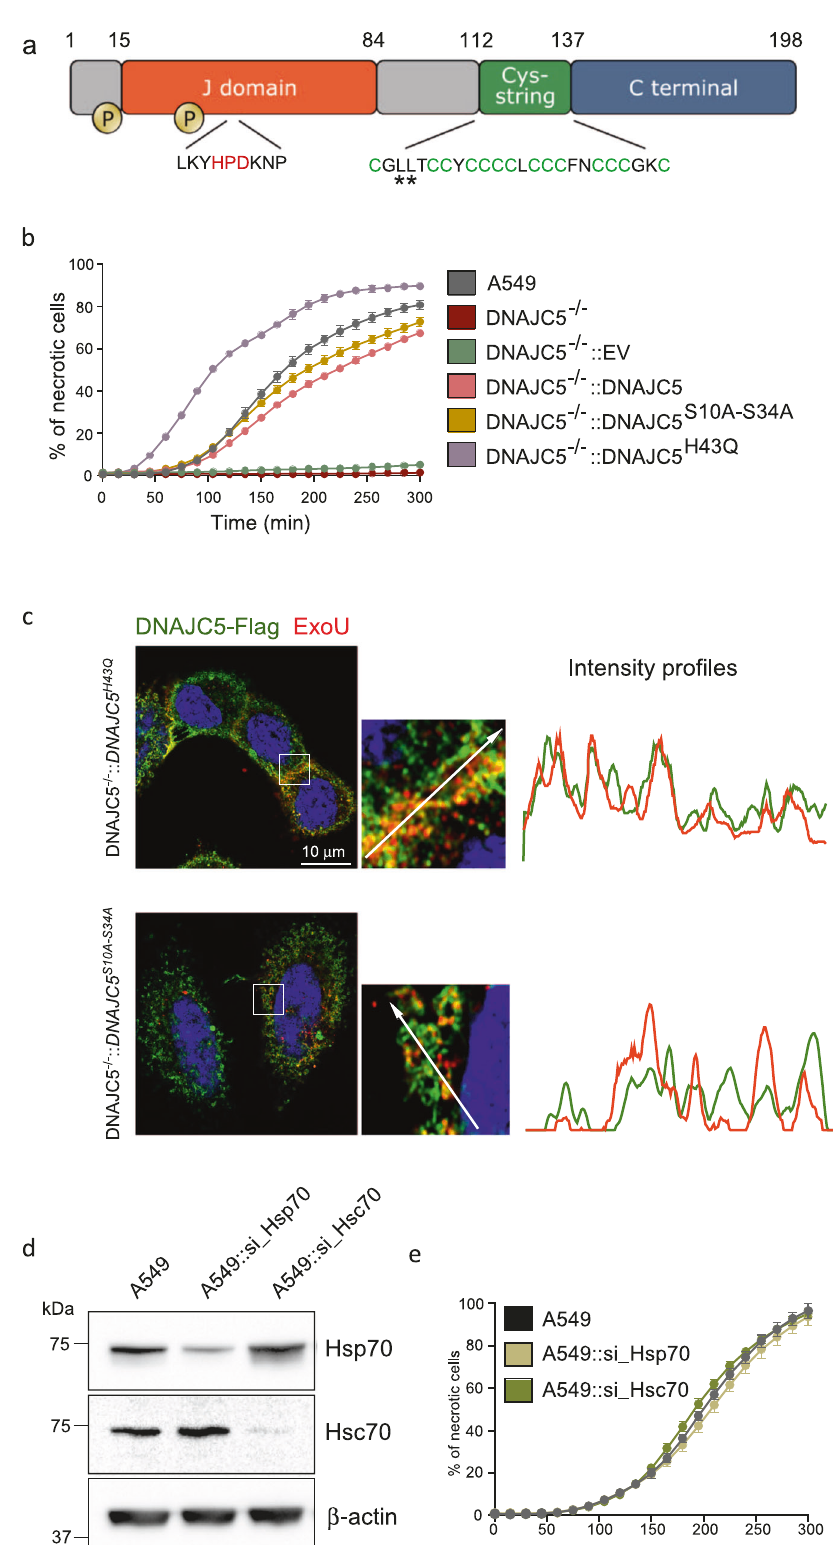
ExoU phospholipase activity is independent of DNAJC5 . To assess whether DNAJC5 contributes to the activation of ExoU enzymatic activity per se, we expressed and puri fi ed recombinant ExoU and examined its catalytic activity in a PLA2 assay, in the presence of membrane or soluble fractions prepared from unin- fected DNAJC5 − / − or DNAJC5 − / − ::DNAJC5 cells. Only the